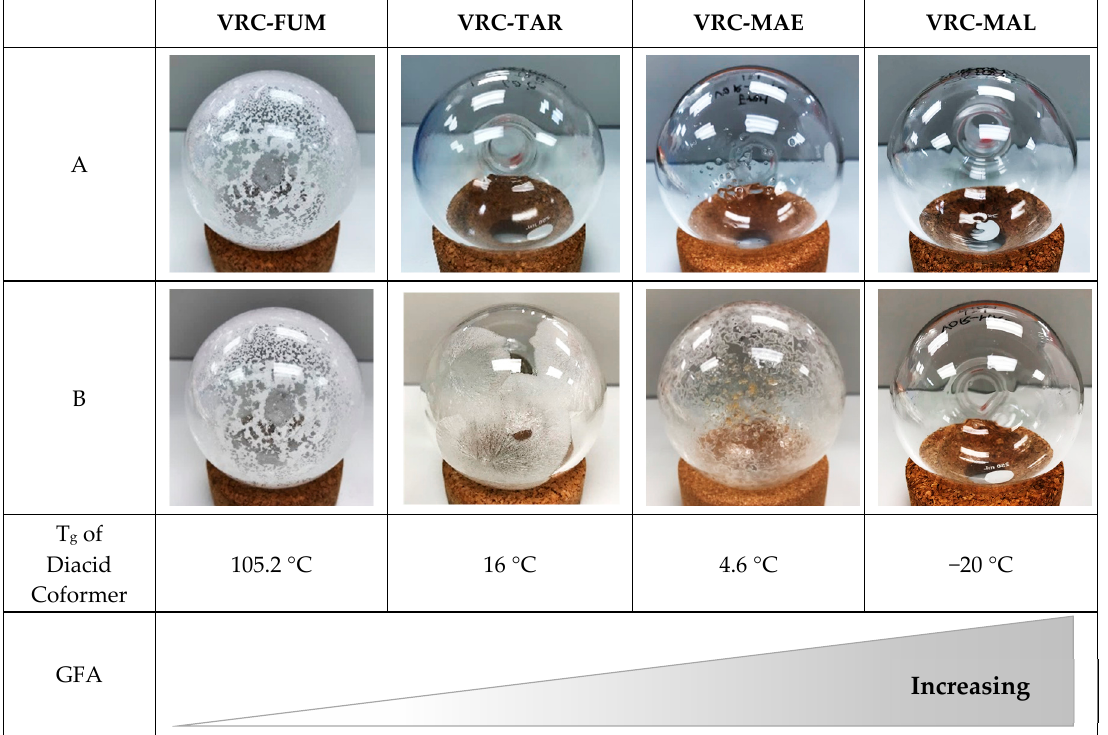
Figure 2. The physical appearance of the products presented in the round bottom flask right after the completion of evaporation ( A ) and 3 days after aging at 60 °C ( B ).